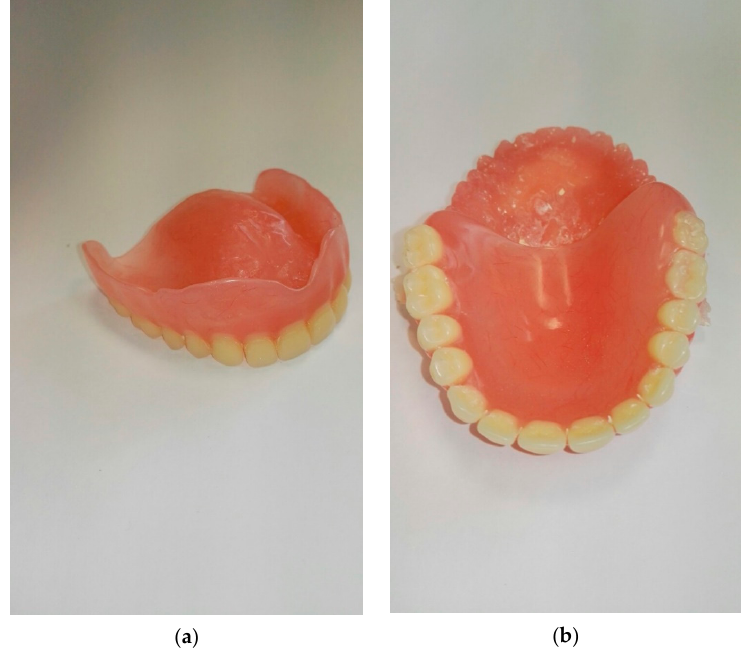
Figure 5. The image of the prepared dental prosthesis made from hybrid composite: base + 2.5% HNT-g + 2.5% ATH-sil, view of the upper ( a ) and lower part ( b ) of the complete denture prosthesis.